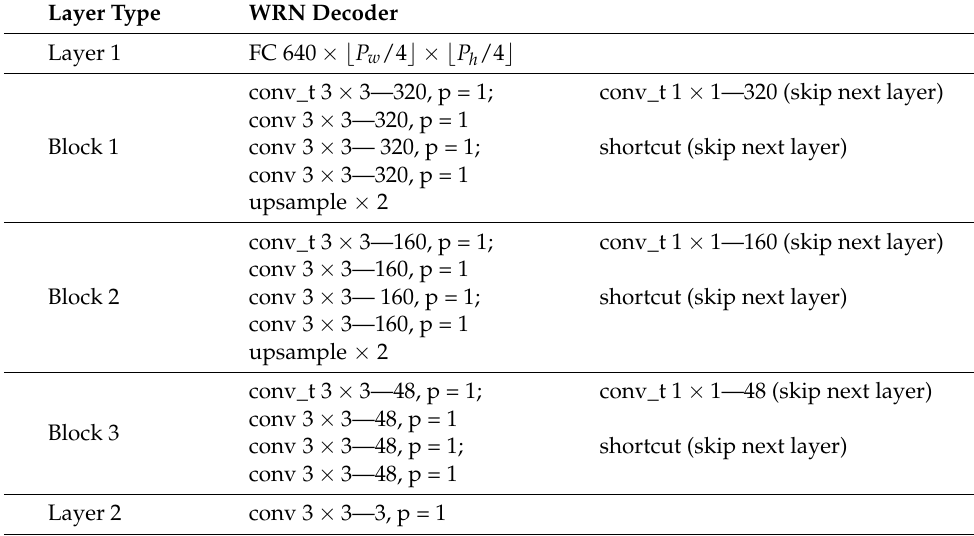
Table A4. A 14-layer WRN decoder with a widen factor of 10. P w and P h refer to the input’s spatial dimension. Convolutional (conv) and transposed convolutional (conv_t) layers are parametrized by a quadratic filter size followed by the amount of filters. p and s represent zero padding and stride, respectively. If no padding or stride is specified, then p = 0 and s = 1. Skip connections are an additional operation at a layer, with the layer to be skipped specified in brackets. Every convolutional and fully-connected (FC) layer is followed by batch-normalization and a rectified linear unit (ReLU) activation function. The model ends on a Sigmoid